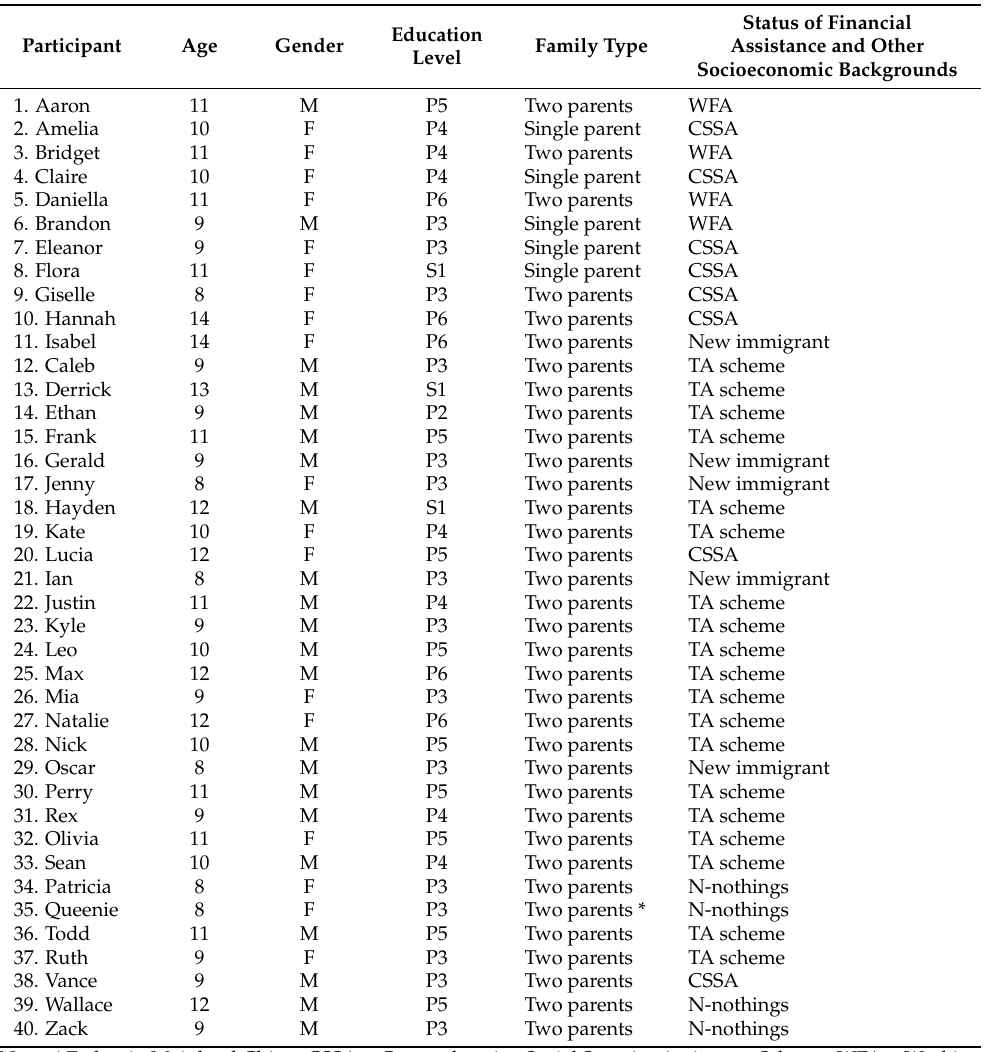
Table 1. Background characteristics of the child